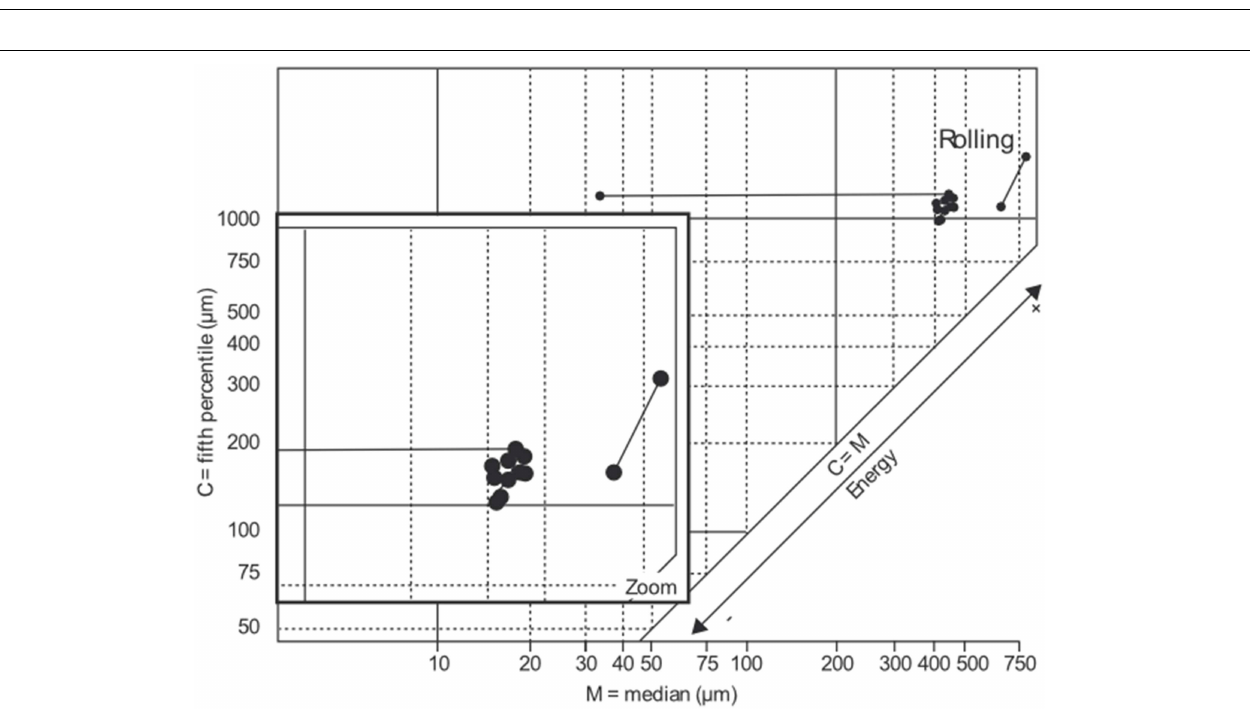
FIGURE 5 | Cumulative grain size curves for 4220 BP and 2002 tsunamis deposits.